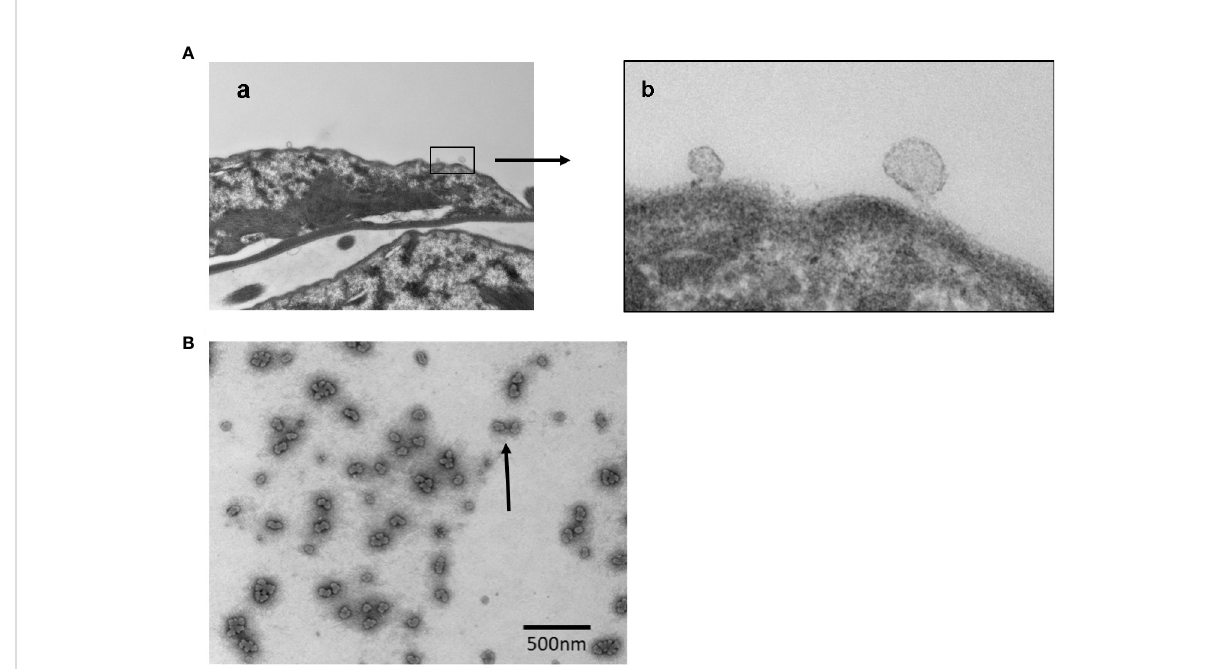
FIGURE 4 Transmission Electron Microscopy (TEM) analysis of vesicle formation and the images of released vesicles by Giardia trophozoites. Panel (A) Images showing (a) the budding of vesicles in lower magni fi cation; (b) vesicles generation in higher magni fi cation. Panel (B) Vesicles (LVs and SVs) released by trophozoites were isolated as mentioned in Materials and Methods and subjected to negative staining before the analysis by TEM. Bar: 500